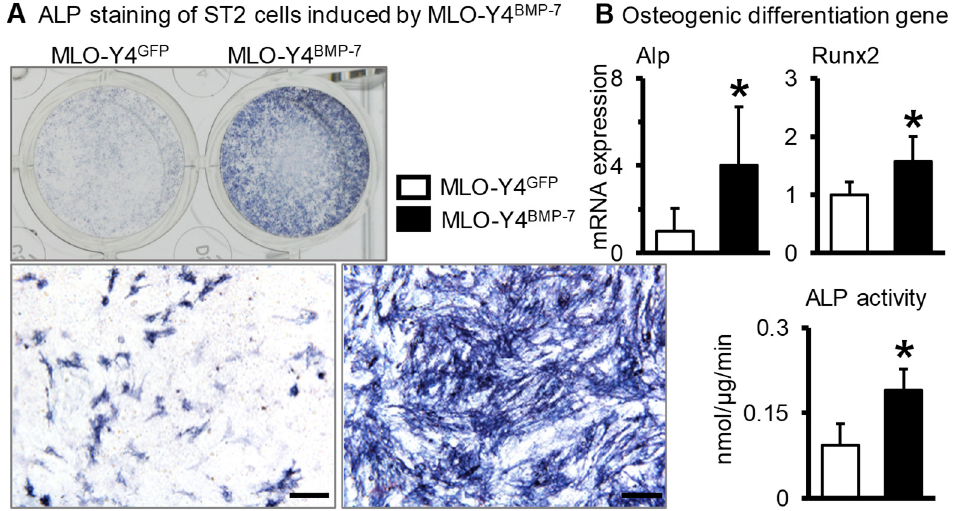
Figure 4. The osteogenic differentiation of ST2 cells when cocultured with BMP-7-overexpressed osteocytes. ( A ). ALP staining and ALP activity in the coculture system of ST2 cells and BMP-7-overexpressed MLO-Y4 cells. ( B ). Osteogenic gene expression in the coculture system of ST2 cells and BMP-7-overexpressed MLO-Y4 cells. * p < 0.05, compared with MLO-Y4 GFP group. Scale bar: 50 μ m.